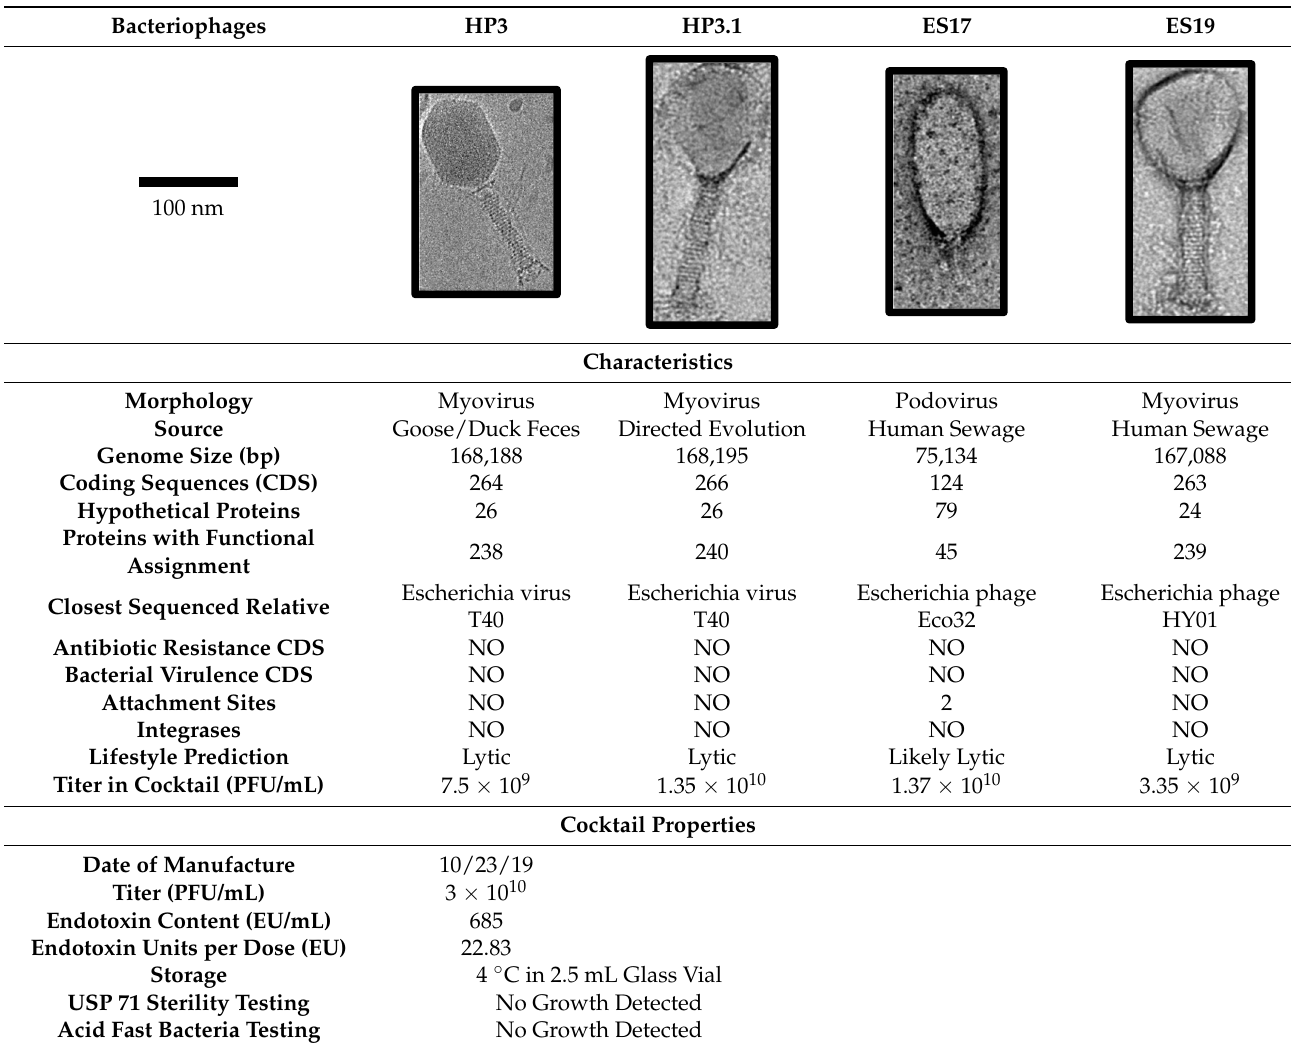
Table 1. Composition, Genomic Analysis, and Properties of UCS1 Escherichia coli Phage Cocktail. Bacteriophages